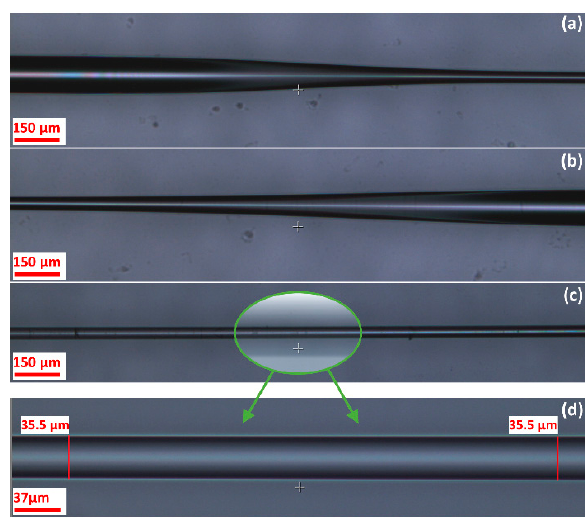
Figure 4. ( a , b ) SMF taper transition, ( c ) long uniform taper waist, ( d ) magnified image of the uniform taper waist.